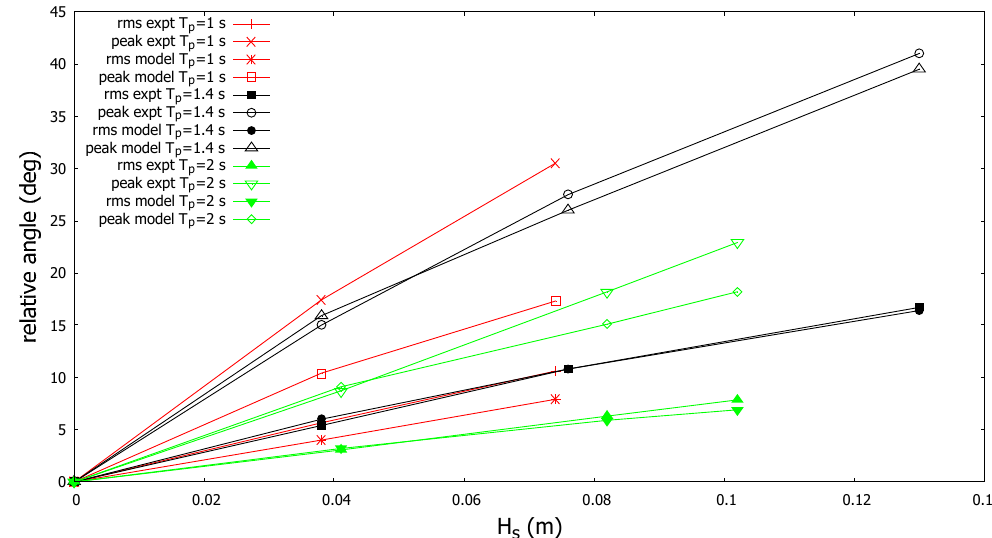
Figure 11. Variation of rms and peak relative angle θ r with H s for T p = 1, 1.4, 2 s from experiment and linear diffraction/radiation model with measured mean force.